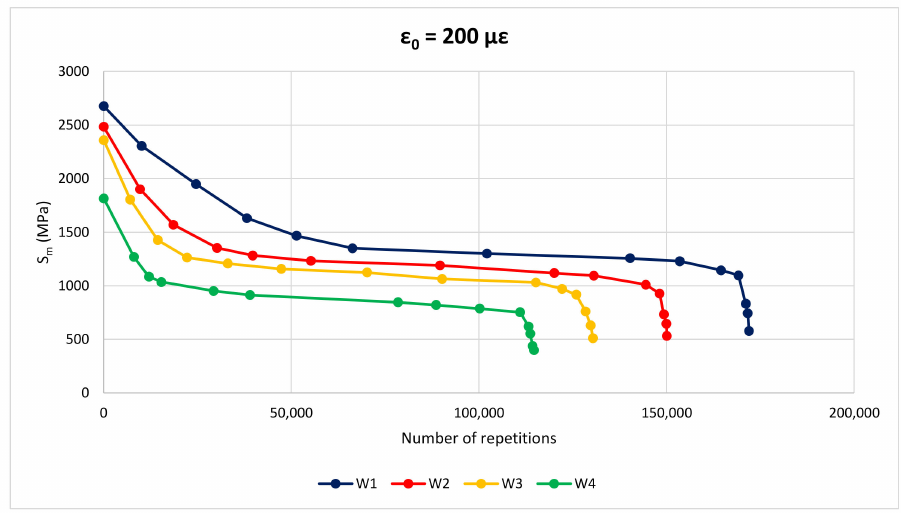
Figure 12. Fatigue curve of wearing layers, ε 0 = 200 µε